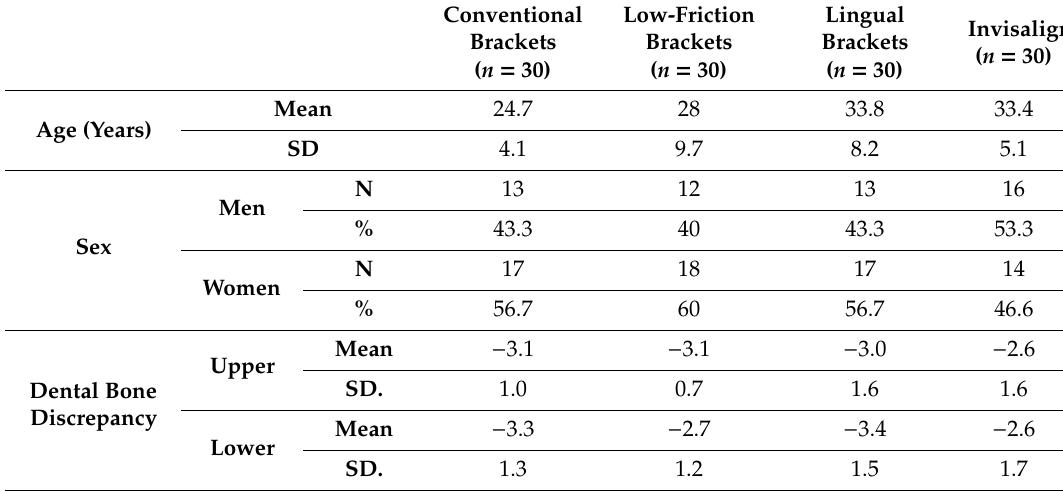
Table 1. Demographic characteristics of participants ( n =